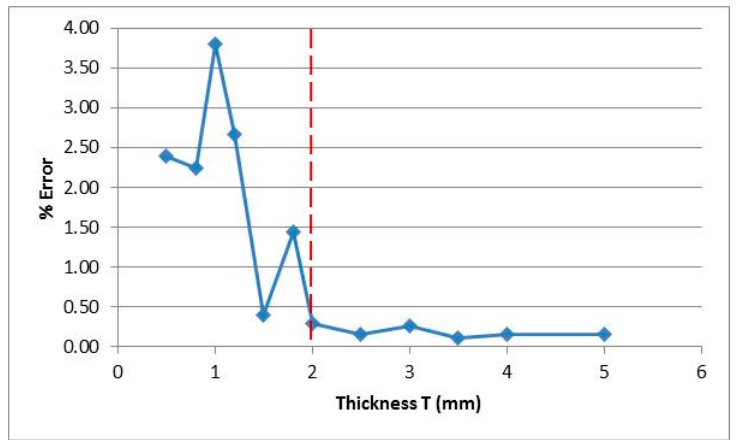
Figure 6. Experimental results show that % error in actual thickness decrease with increasing sample thickness. The % error reduces less than 0.3% for thickness greater than 2 mm.